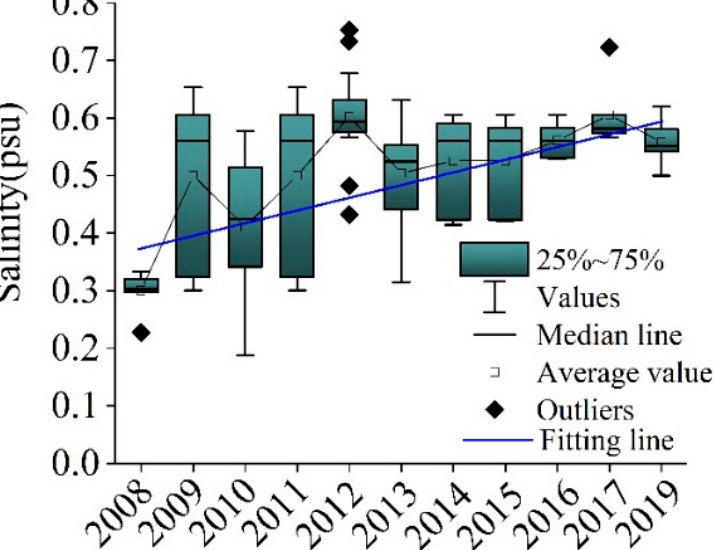
Figure 6. The tendency of salinity in Chagan Lake from 2008 to 2018. Each boxplot illustrates the median and inter-quartile range and the whiskers indicate minimum and maximum values. The blue solid line indicates the fitting line of salinity. The black points indicate the outliers.